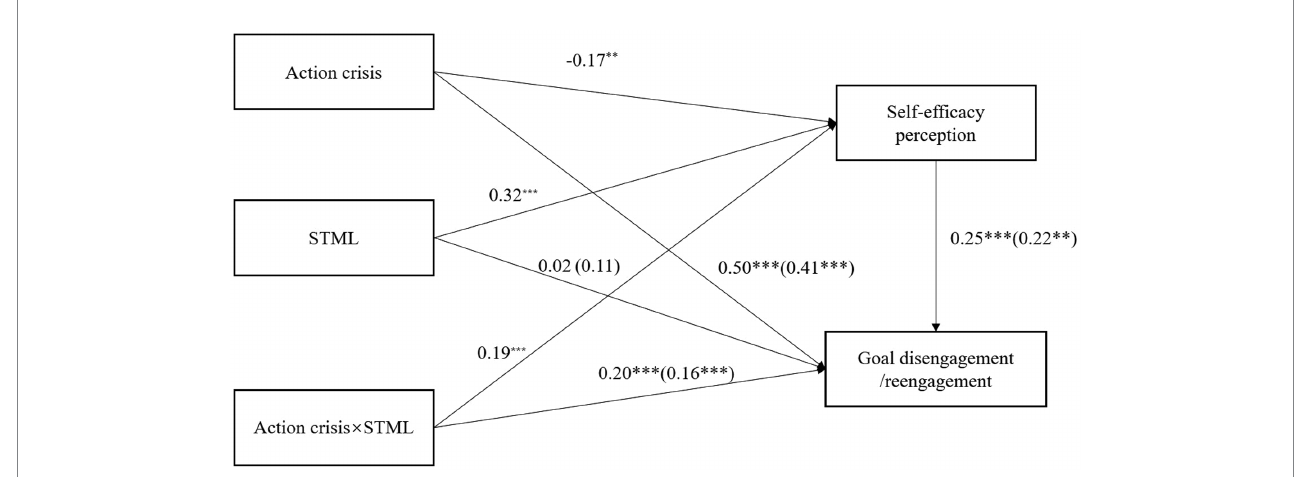
FIGURE 5 The mediation effect of perceived self-efficacy between the action crisis × STML interaction on goal disengagement and reengagement in Study 2. STML, self-transcendence meaning of life. The effects on goal reengagement are in parentheses. Some paths have no parentheses because the effects are the same for the two models. ** p < 0.01; *** p < 0.001.